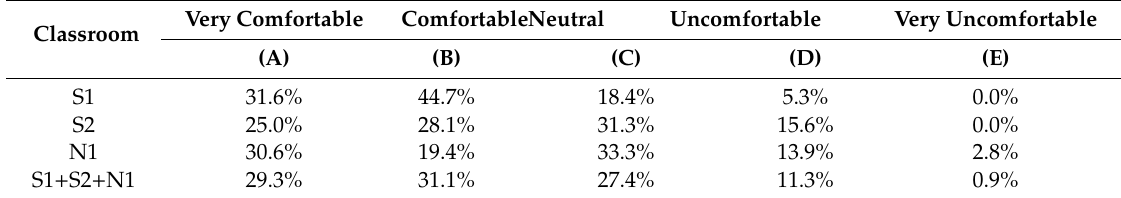
Table 9. S1, S2 and N1 window opening comfort votes. 220